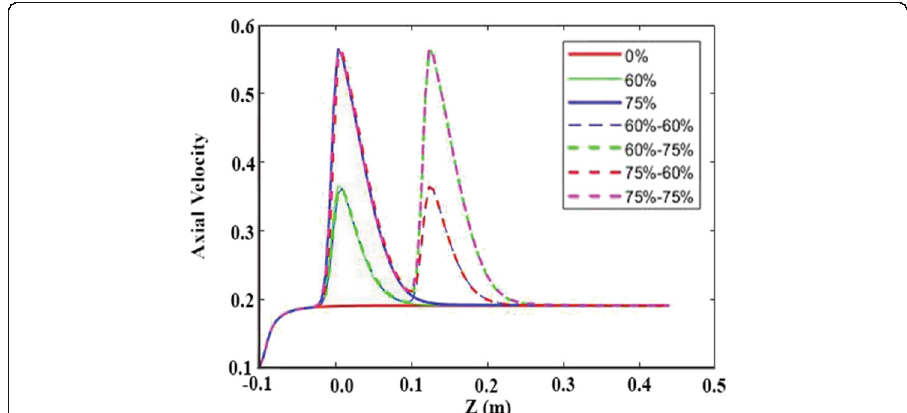
Fig. 3 Changes in axial velocity in normal artery and arteries with single and multiple stenosis